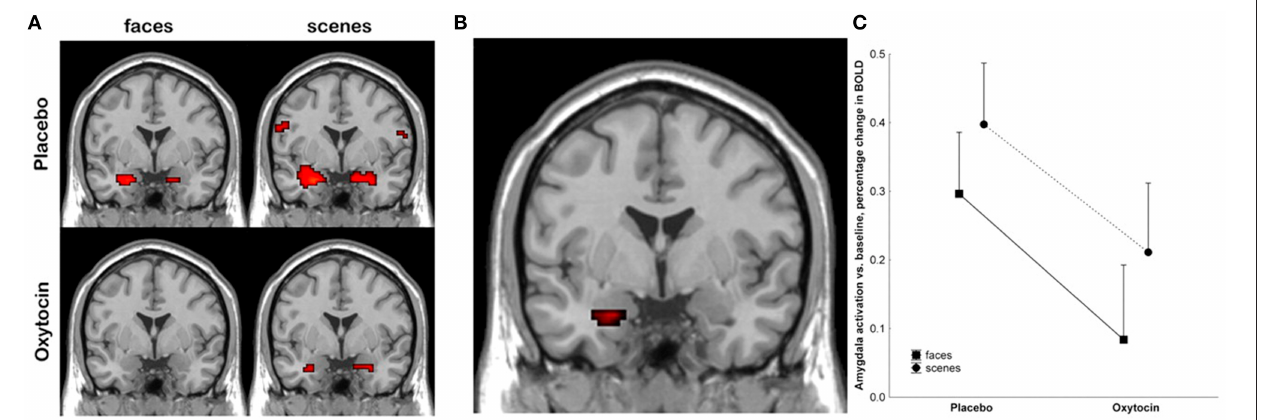
FIGURE 3 | Kirsch et al. (2005) showed that oxytocin attenuated amygdala activation in response to fearful stimuli. (A) shows activation at the amygdala, with neural responses to fearful faces shown on the left, and to fearful scenes on the right, under placebo conditions (top), and after treatment with oxytocin (bottom). (B) shows the main effect of the drug in the left amygdala, where the signal was strongest. (C) plots BOLD levels at the amygdala using a region of interest analysis. Reproduced with permission from J. Neurosci. (Kirsch et al.,